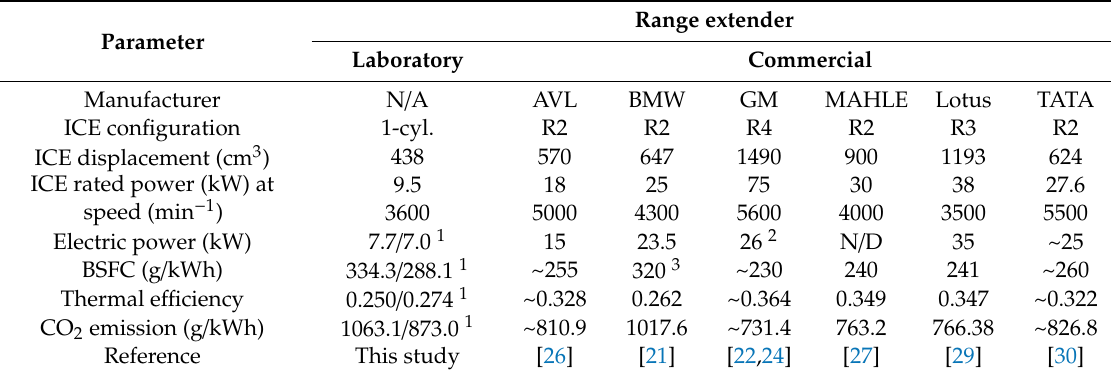
Table 7. Comparison of the tested laboratory range extender with commercially available